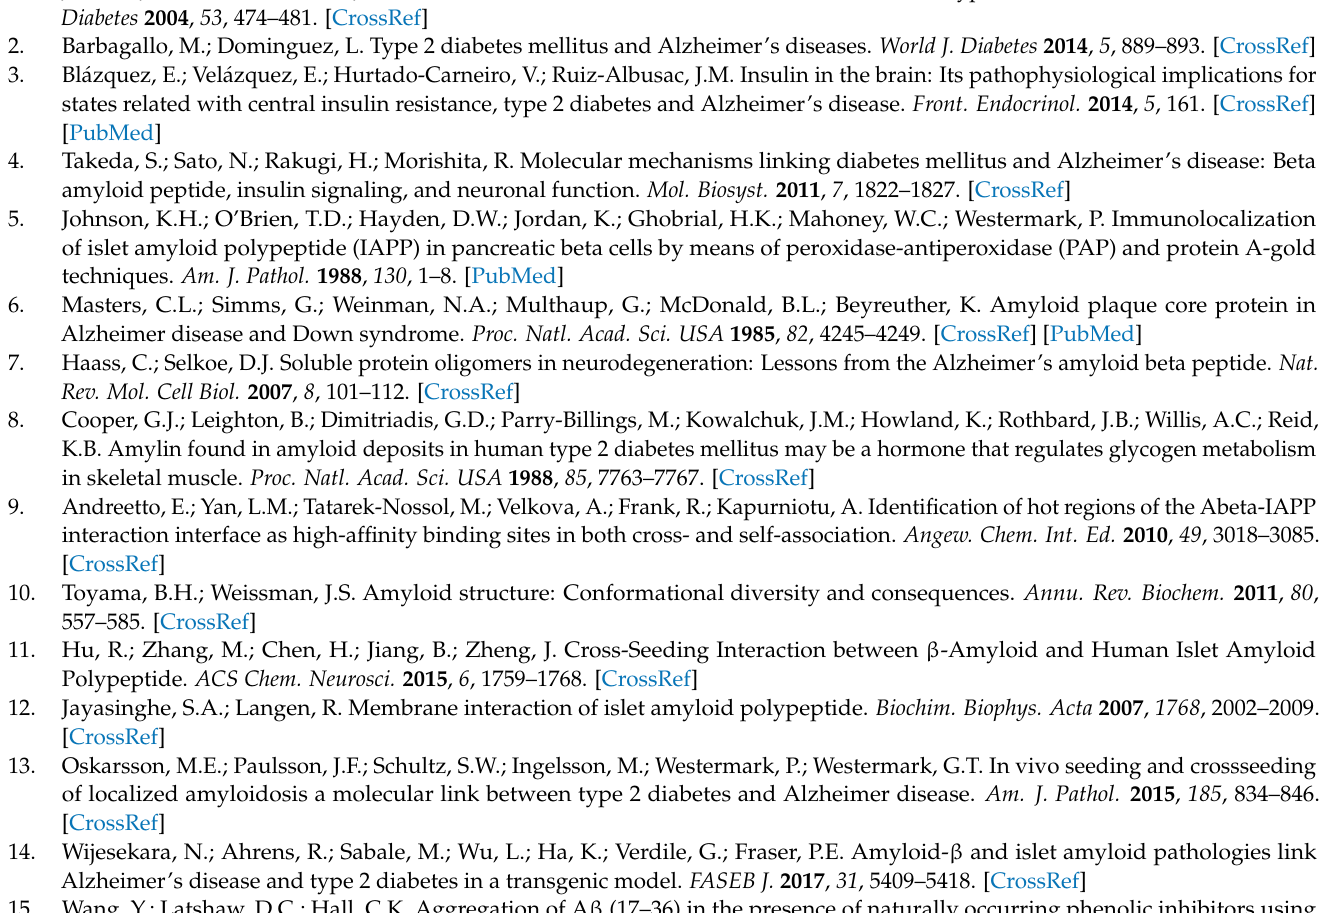
Figure S5: Efficacy of compounds 1 , 3 , 5 , 7 , 8 , and EGCG against pre-existing A β 42 aggregates. Figure S6: Efficacy of compounds 1 , 3 , 7 , and 8 against pre-existing A β 42 aggregates visualized by use of TEM. Figure S7: Efficacy of compounds 1 , 3 , 5 , 7 , 8 , and EGCG against pre-existing hIAPP aggregates. Figure S8: Efficacy of compounds 1 , 3 , 7 , and 8 against pre-existing hIAPP aggregates visualized by use of